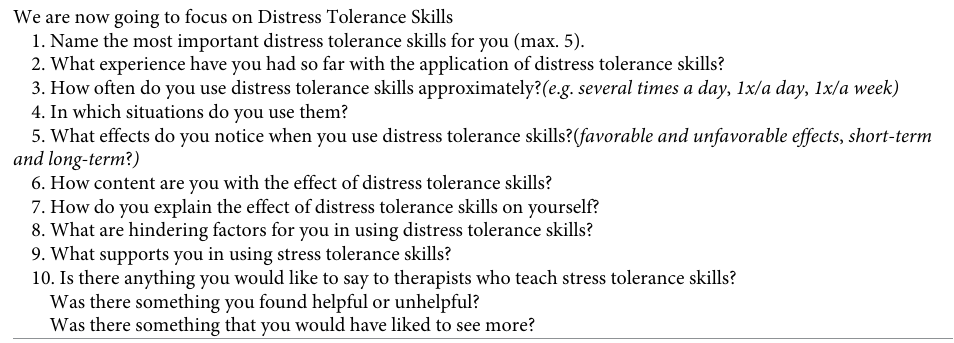
Table 1. Qualitative interview on components of dialectical behavior therapy–Distress Tolerance